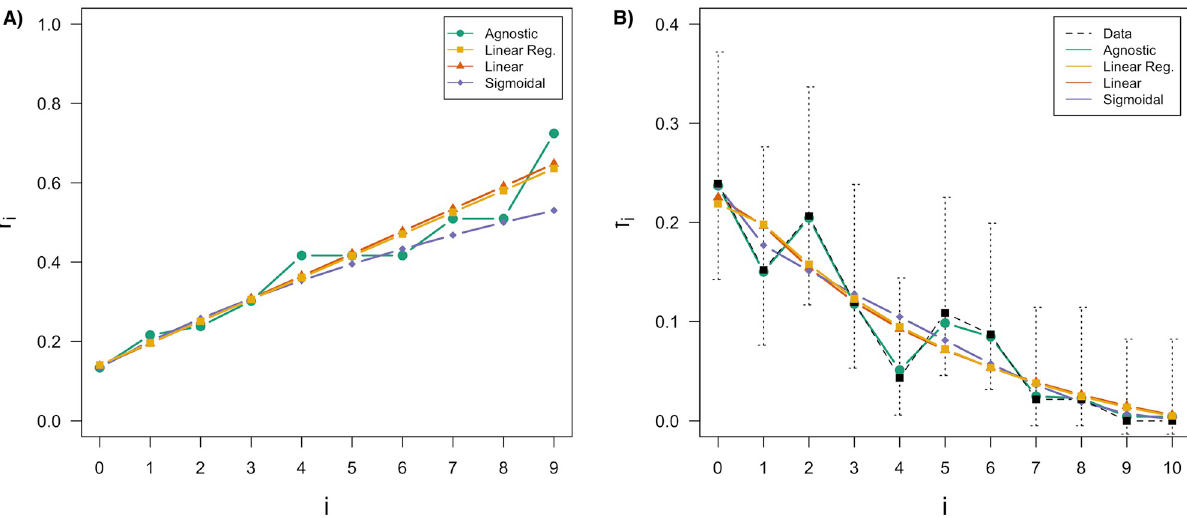
Fig 3. Single point estimation (parametrisation minimising the L2 distance between the rational functions and data). (A). For comparison, rational function values (coloured lines), data (dashed line), and 90% confidence intervals computed from data points (black error bars) (B). On each graph, the results are shown for the agnostic model (green), a linear regression on the agnostic points (yellow), the linear model (red) and the sigmoidal model (blue).